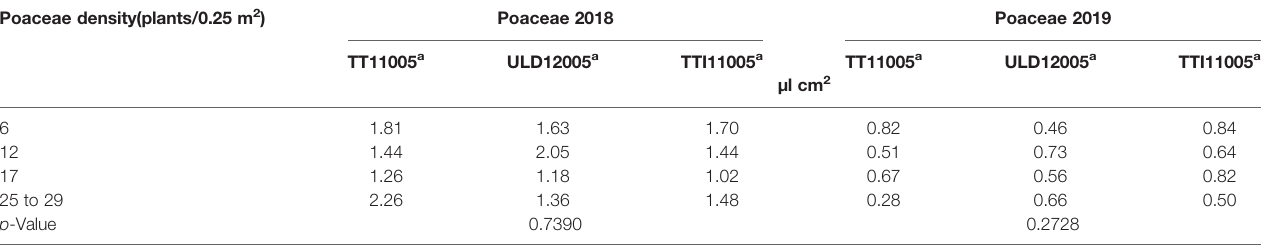
TABLE 6 | Herbicide spray solution deposition onto Poaceae plants as in fl uenced by grass density and nozzle design. Poaceae density(plants/0.25 m 2